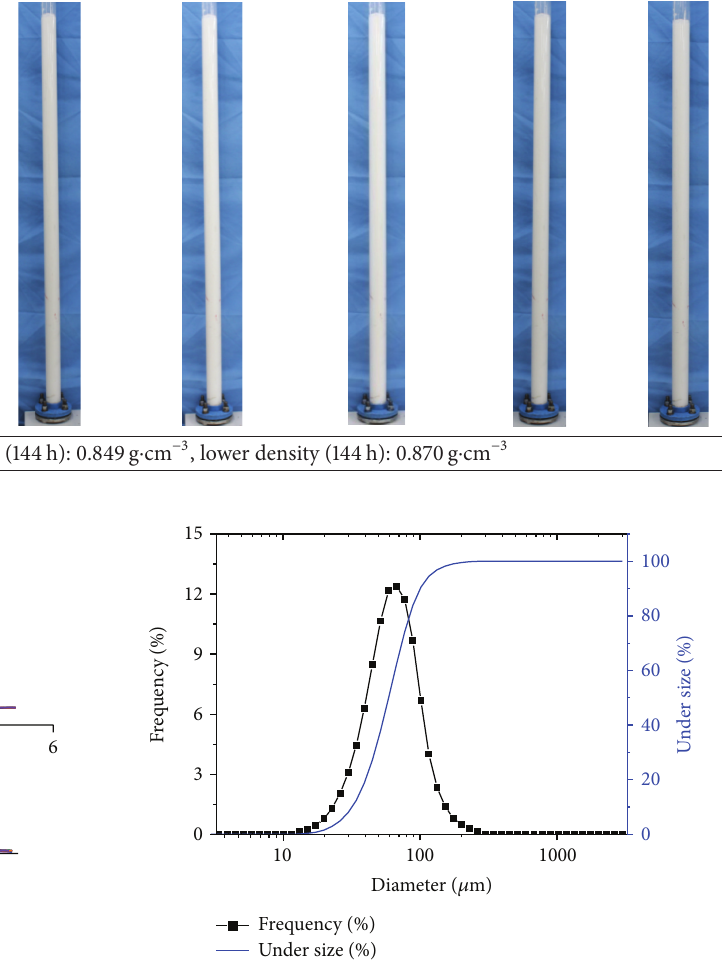
Figure 9: Particle size distribution of polymer drilling fluid with micron-grade